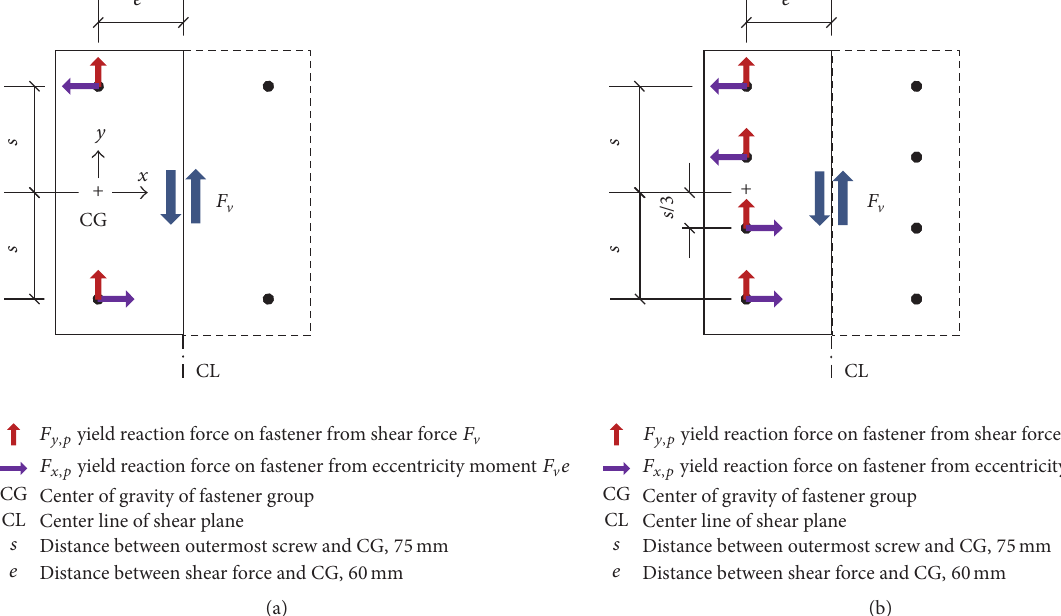
Figure 16: Connection plate subjected to shear force according to Figure 3(b): (a) fastener forces for a double screw configuration and (b) fastener forces for a four-screw